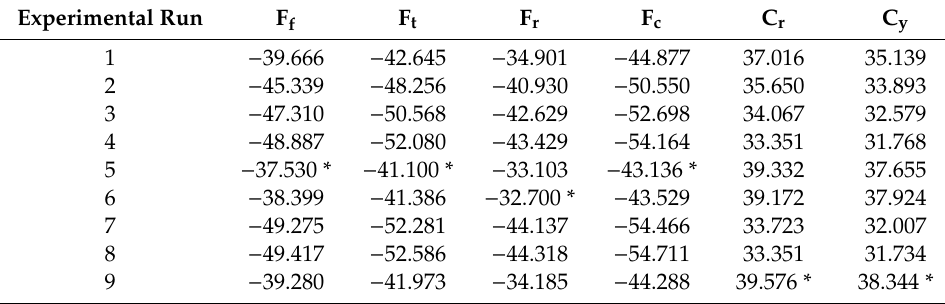
Table 5. Signal to noise ratio values of measured